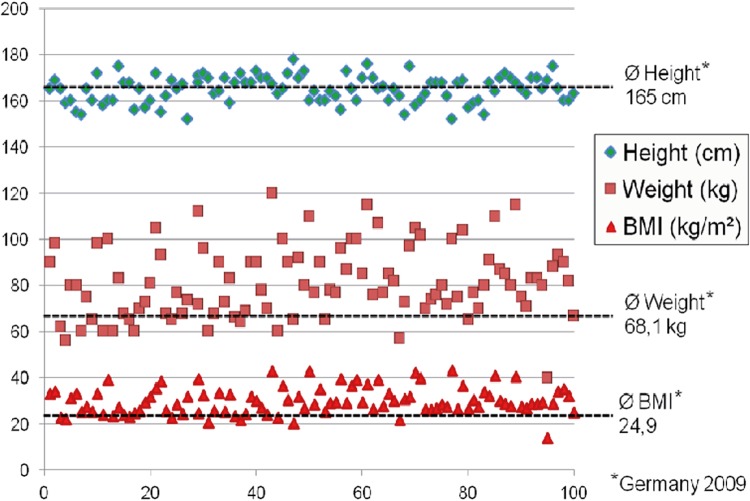
Age ranged from 43 to 86 years (mean 70.3 years). The body-mass-index (BMI) of the patients is predominantly clear above the German average.